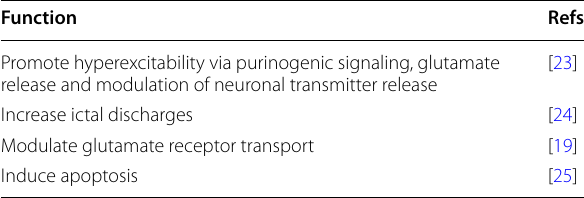
Table 1 Roles of TNFα in